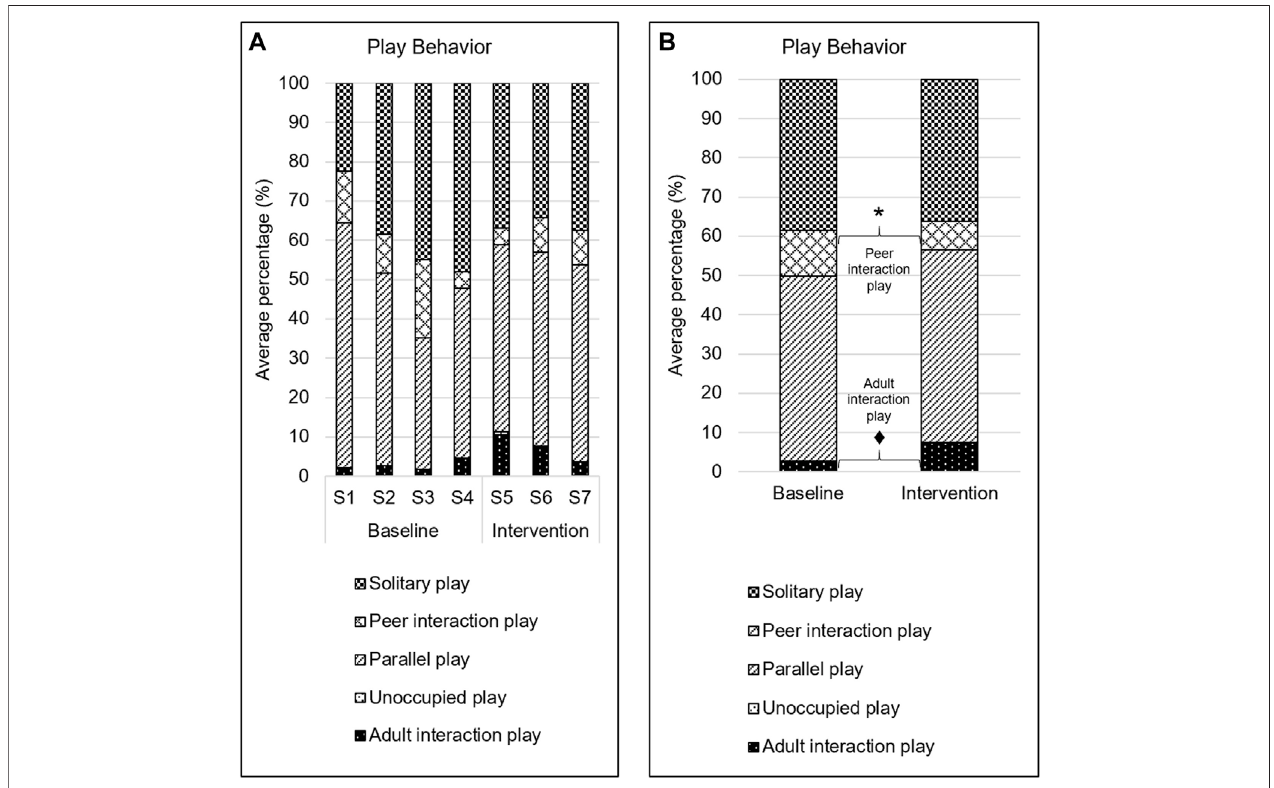
FIGURE 3 | Play behavior. A . Average percentage of intervals spent in each type of play behavior. S# on the x -axis represents the session number. B . Average percentage of intervals spent in each type of play behavior during baseline and intervention phases. * → p < 0.05; ◆ → p < 0.06.